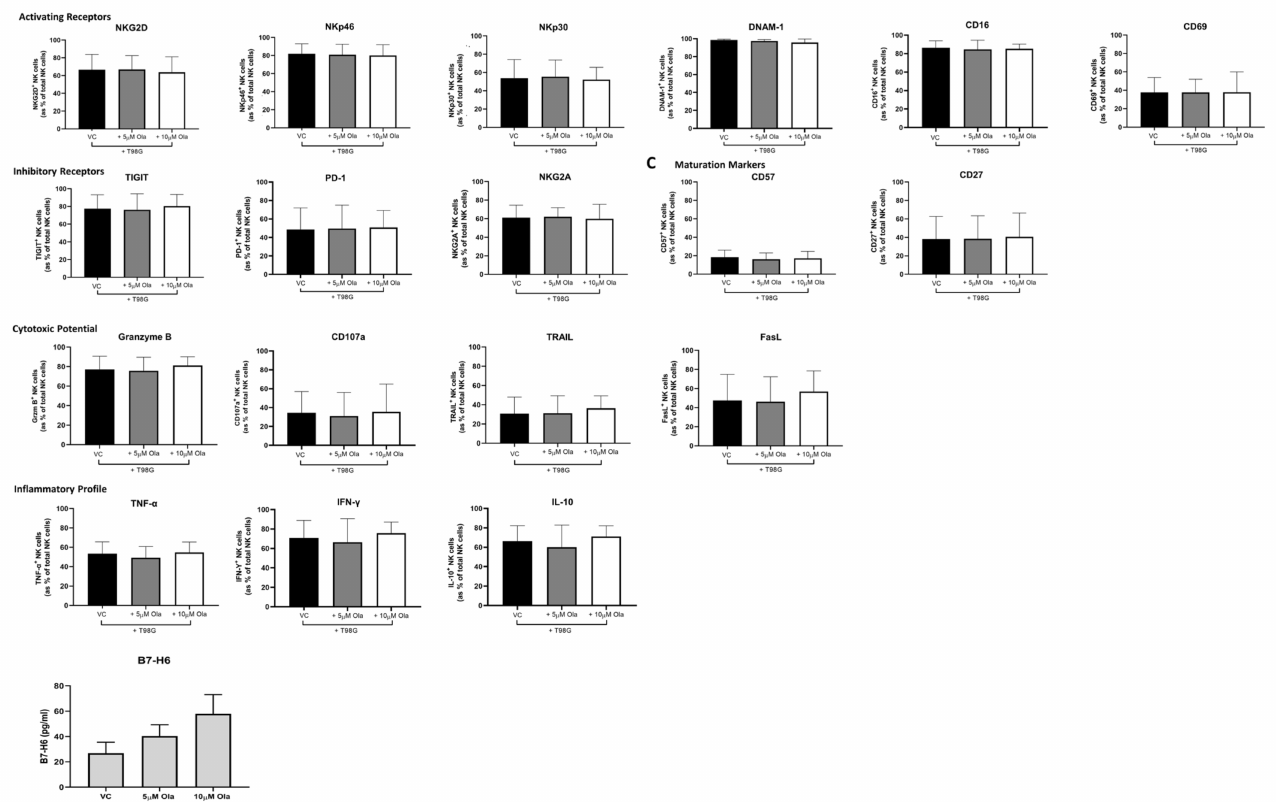
Figure 4. Concurrent Olaparib treatment and co-culture with T98G cells did not alter the phenotype, cytotoxic potential, or inflammatory profile of healthy donor-derived NK cells. Bar chart showing % frequencies of NK cells expressing ( A ) NKG2D, NKp46, NKp30, DNAM-1 (activating receptors), ( B ) TIGIT, PD-1, NKG2A (inhibitory receptors) ( C ) CD57, CD27, CD69, CD16 (maturation markers), ( D ) TRAIL, FasL, CD107a, Granzyme B (cytotoxic markers), and ( E ) TNF- α , IFN- γ , IL-10 (inflamma- tory markers) as % of total NK cells, following co-culture with T98G cells (black) and treatment with 5 µ M (grey) or 10 µ M (white) of Olaparib for 24 h (all n = 6) [DNAM-1, CD16 n = 3]. ( F ) Bar chart showing soluble B7-H6 in the secretome of T98G cells treated with vehicle control (VC) or 5 µ M or 10 µ M of Olaparib for 24 h ( n = 3). One-way ANOVA with post hoc Dunn’s